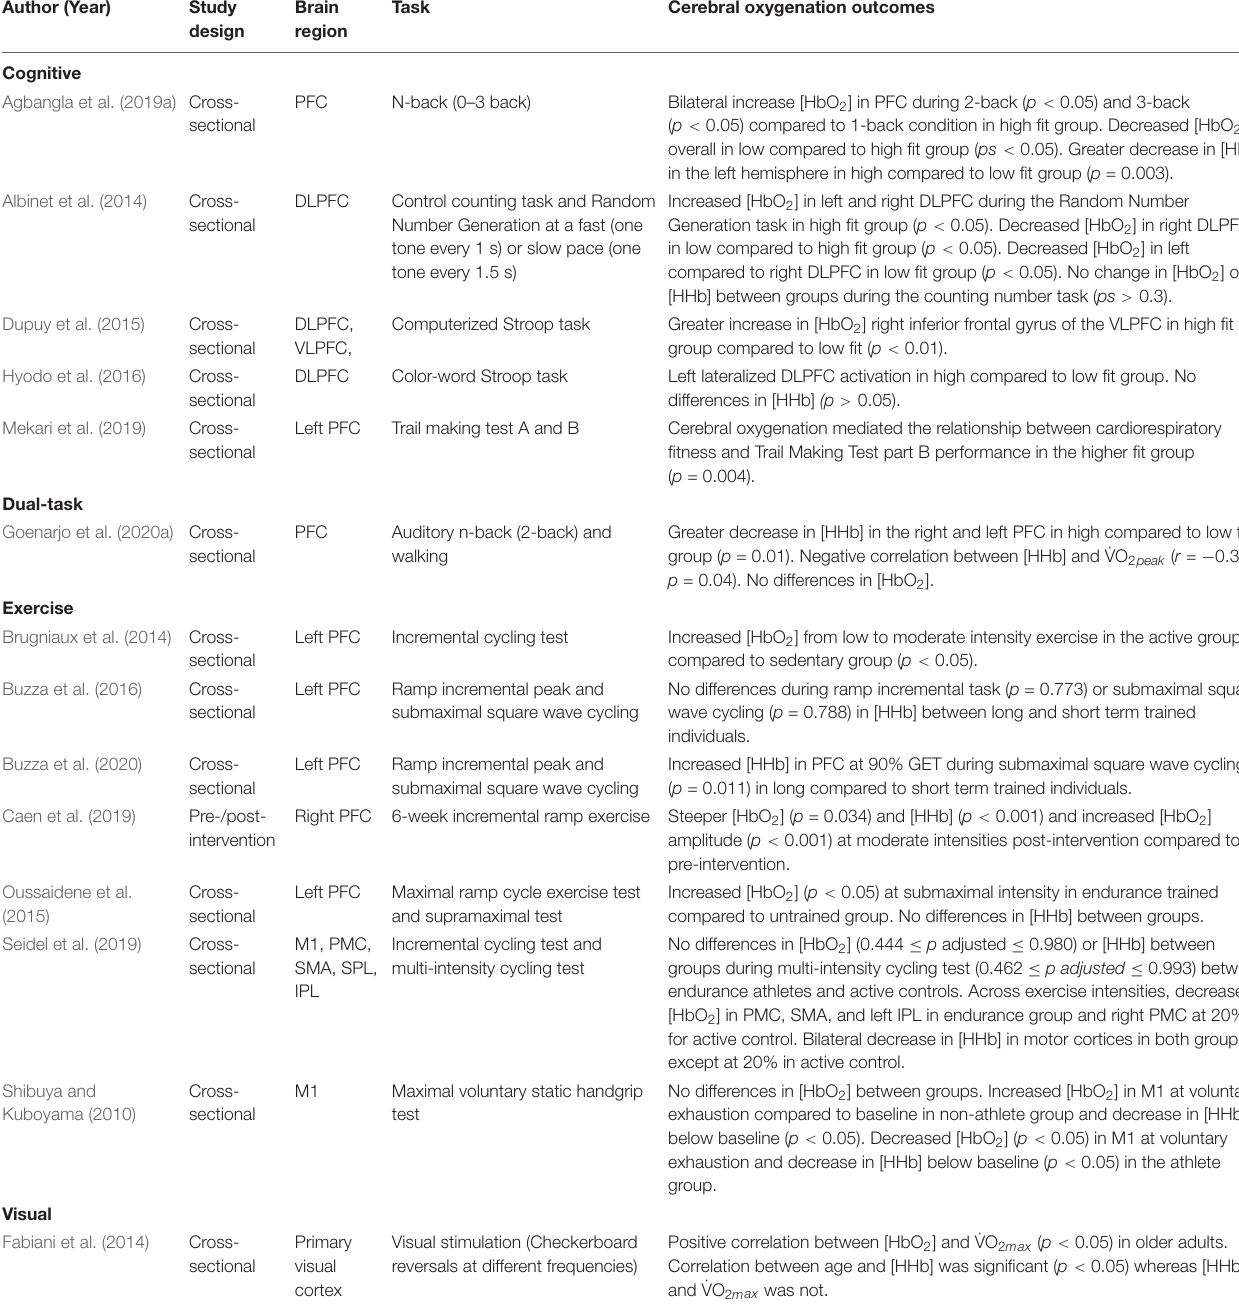
TABLE 1 | Study characteristics of included